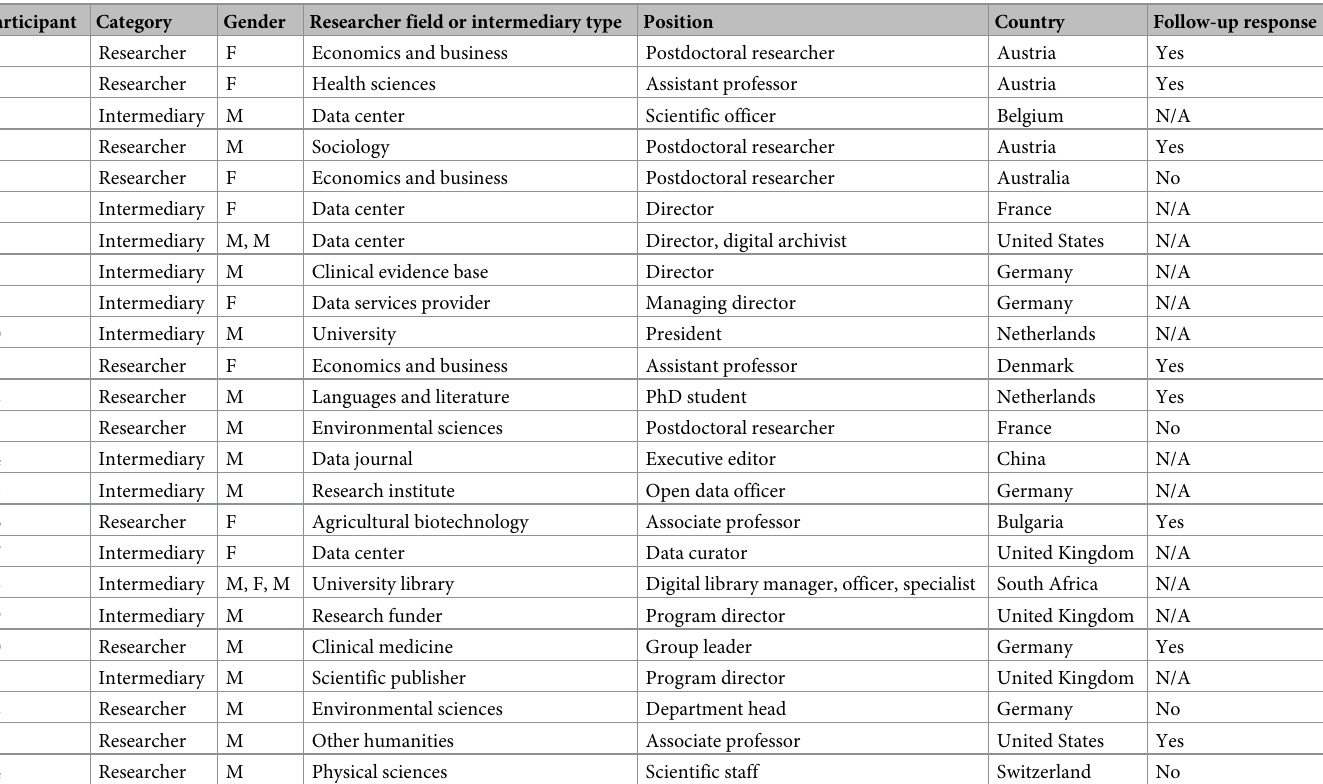
Table 1. Characteristics of the study